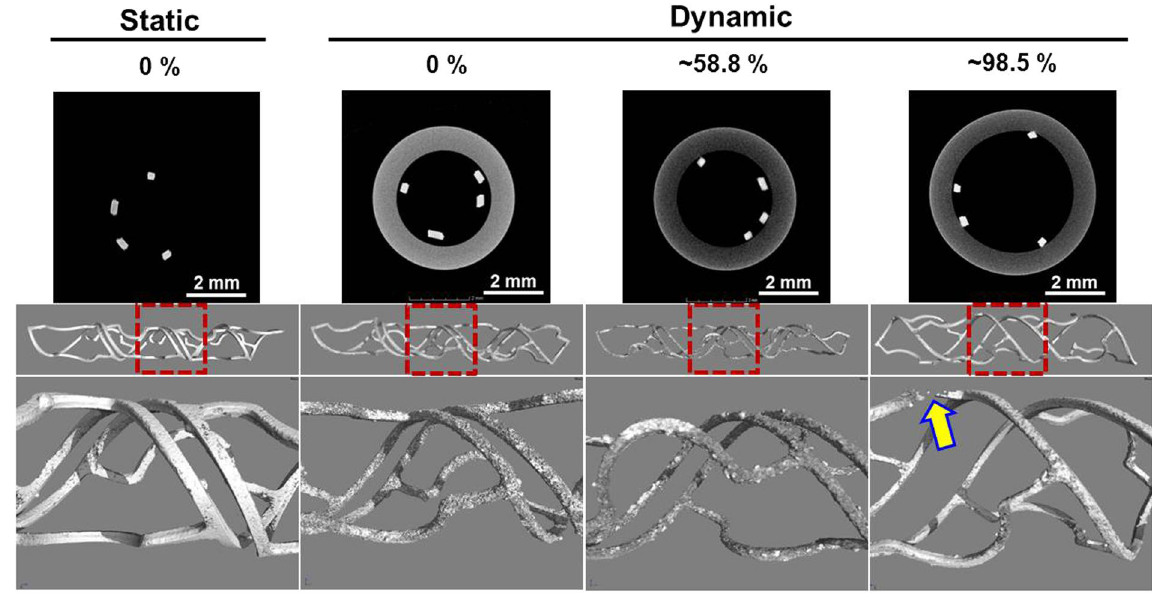
Figure 4. Cross-sectional 2D (before test) and 3D (after test) micro-CT structure images revealing corrosion products accumulated during the in vitro static and dynamic fluid flow simulations for 3 days in DMEM (10% FBS, 1% P/S) at 37 °C, 5% CO 2 . Red dot box images were enlarged. Yellow arrow indicates broken strut after in vitro dynamic fluid flow simulation.